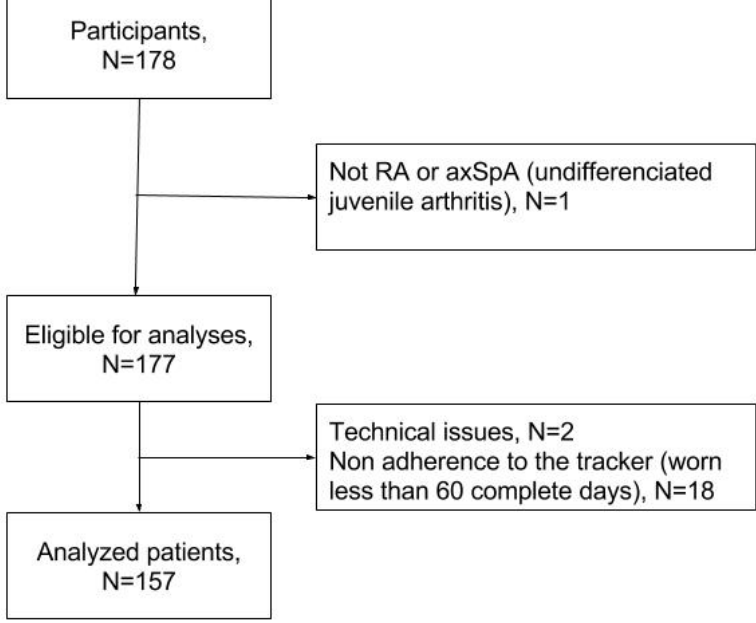
Figure 1. Flowchart of 178 included RA and axSpA patients. RA: rheumatoid arthritis; axSpA: axial spondyloarthritis.